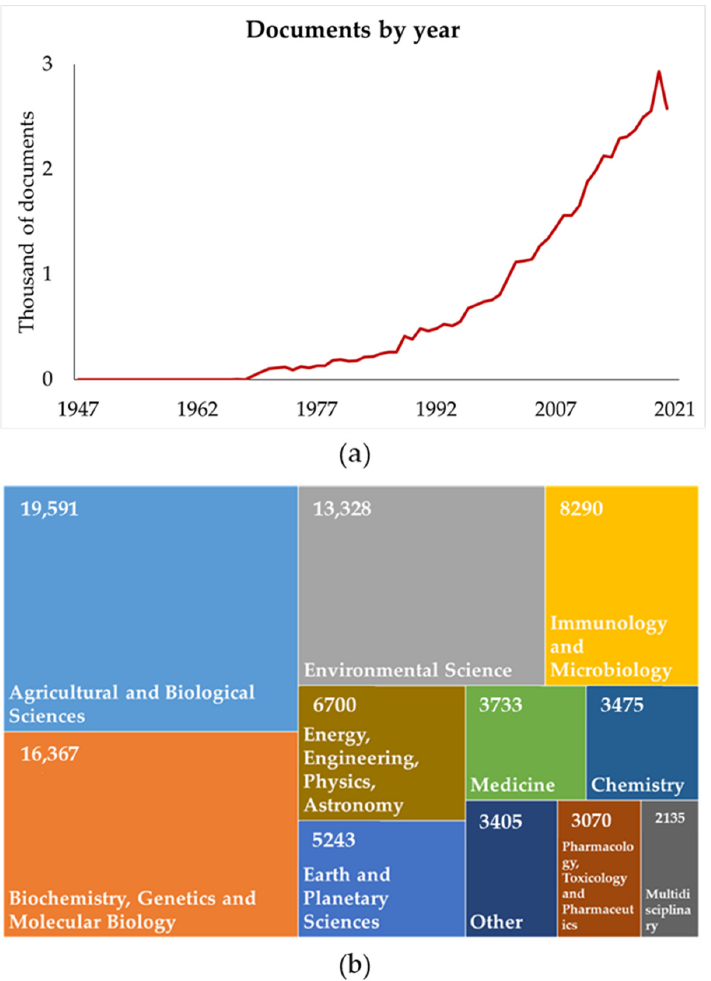
Figure 1. Scientific documents on cyanobacteria by year ( a ) and by subject area ( b ) reviewed in the Scopus ® database (updated to October 2021). Other: Materials Science, Computer Science, Social